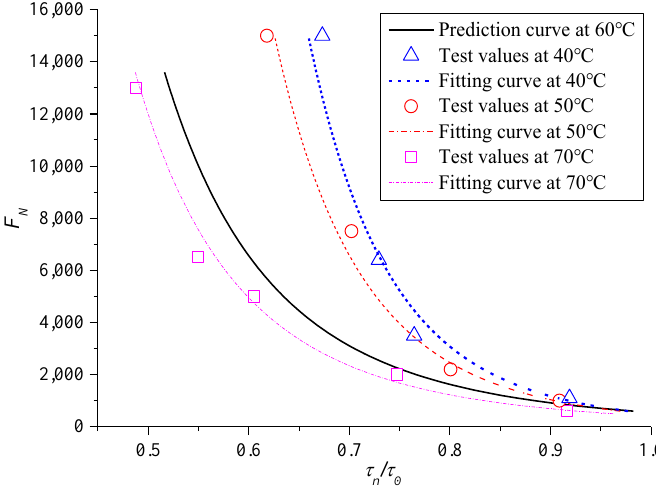
Figure 17. Comparison of F N values at different temperatures.